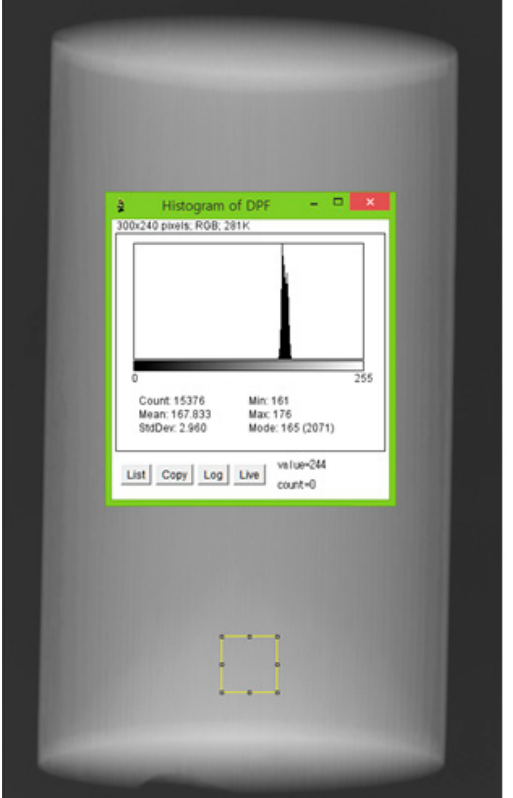
Figure 4. ROI and Histogram.